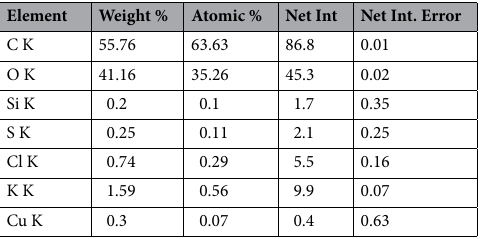
Table 1. Elemental analysis results of the archaeobotanical